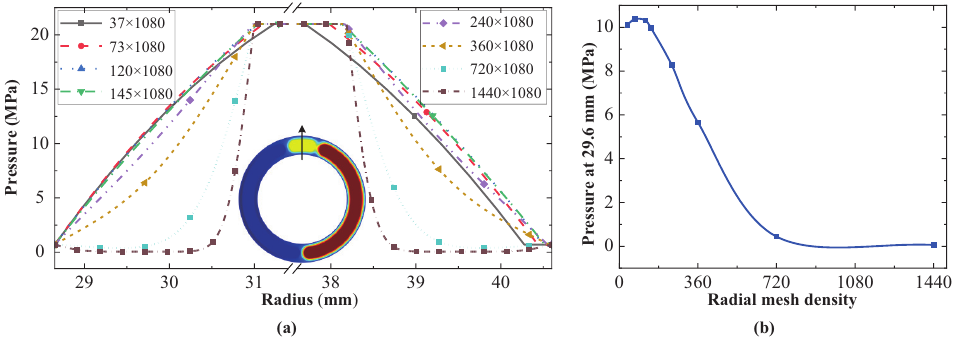
Figure 13. Mesh independence test results of the radial mesh. ( a ) Variation in radial pressure with mesh density. ( b ) Mesh pressures at the radius of 29.6